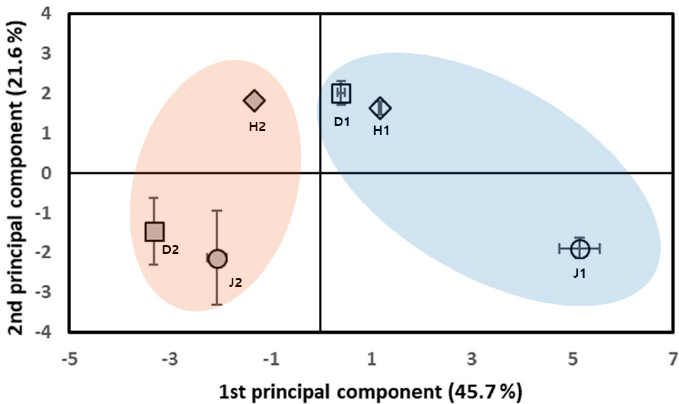
Figure 4. Principal component (PC) plot for FAME composition obtained from sewage sludge. J1 and J2 depict the PS and WAS from the “J” STP, respectively. Abbreviations were similarly applied to the other samples.